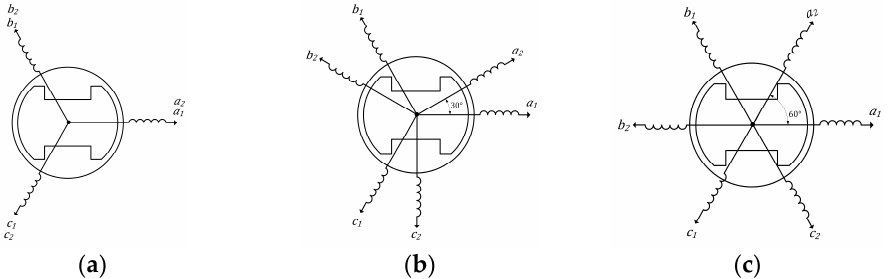
Figure 5. ( a ) Dual three-phase machine; ( b ) asymmetrical six-phase machine; ( c ) symmetrical six-phase machine.